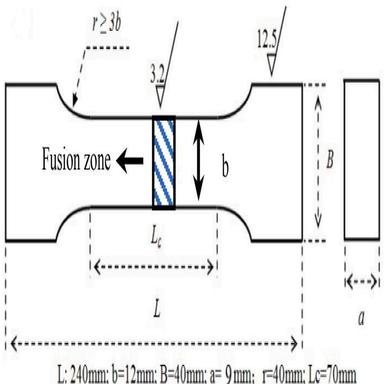
The dimension of fatigue samples.